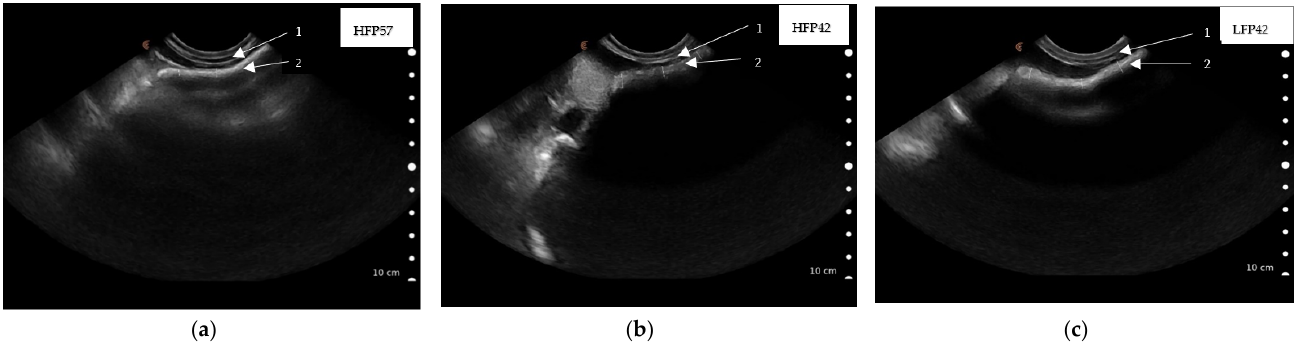
1 Effect of individual lamb within treatment; 2 The effect of replicate Ultrasound scanned image captured from each lamb. a, b Means in the same row with different superscripts are significantly different ( p < 0.05).